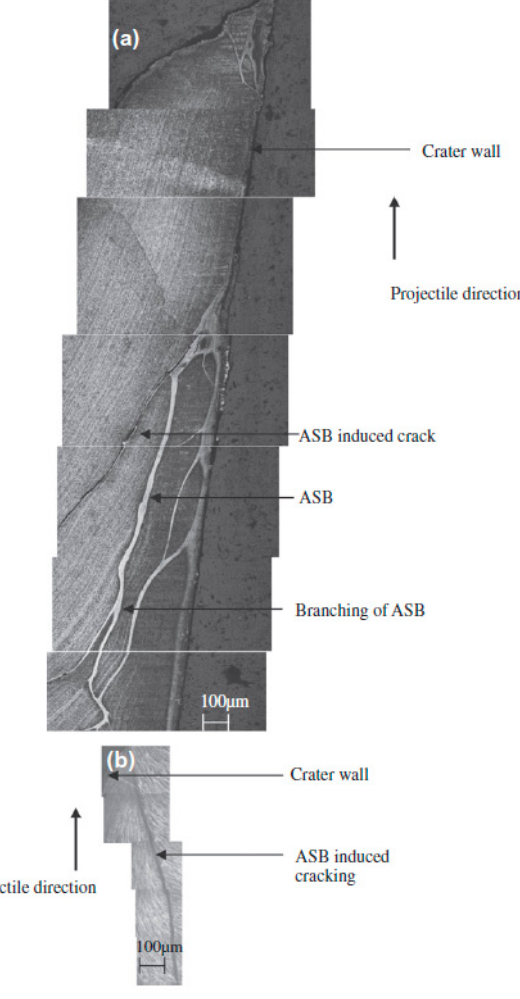
Figure 12. Micrograph of the through thickness of (HHS + Al-alloy; HHS-High Hardness Steel configuration ( a ) front HHS steel plate ( b ) backing Al-alloy plate. The arrow shows the direction of the projectile [47]. Reprinted with permission from Elsevier: Mater. Des. , Copyright 2021, License: 5017591074019.